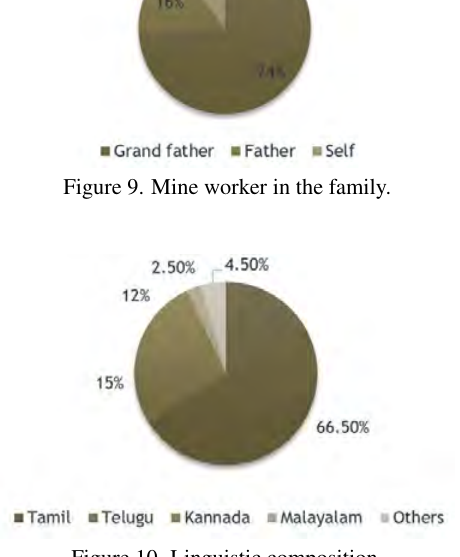
Figure 10. Linguistic